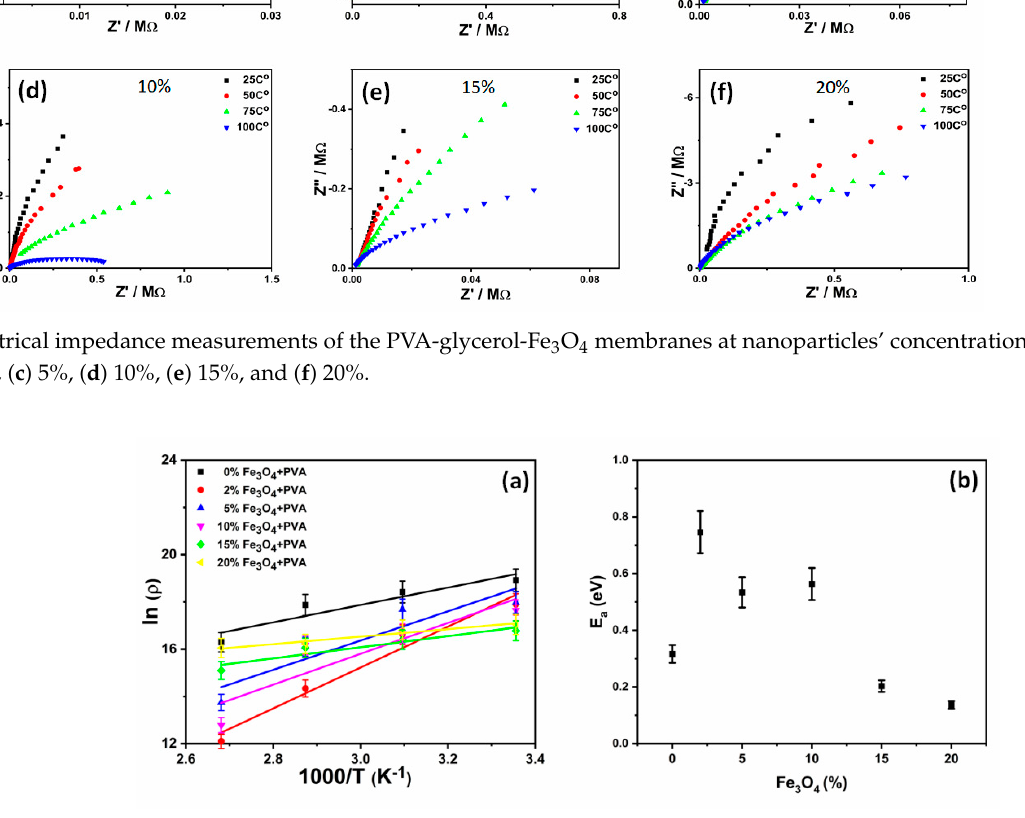
Figure 6. ( a ) The dependence of resistivity (natural logarithm) on inverse temperatures (1000/T) for the PVA-glycerol-Fe 3 O 4 membranes at different wt% concentrations of nanoparticles, and ( b ) the dependence of the activation energy on the wt% concentrations of the nanoparticles.